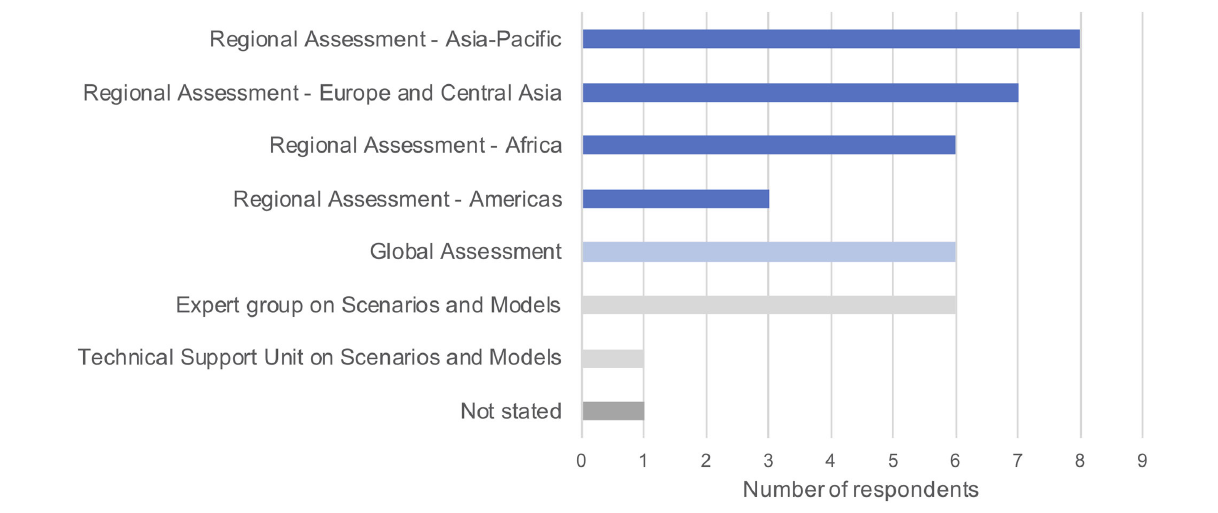
Fig. 1 . Involvement of respondents in individual Intergovernmental Science-Policy Platform for Biodiversity and Ecosystem Services (IPBES) assessments and groups (n = 30). Some respondents reported multiple roles within IPBES, therefore the counts add up to more than